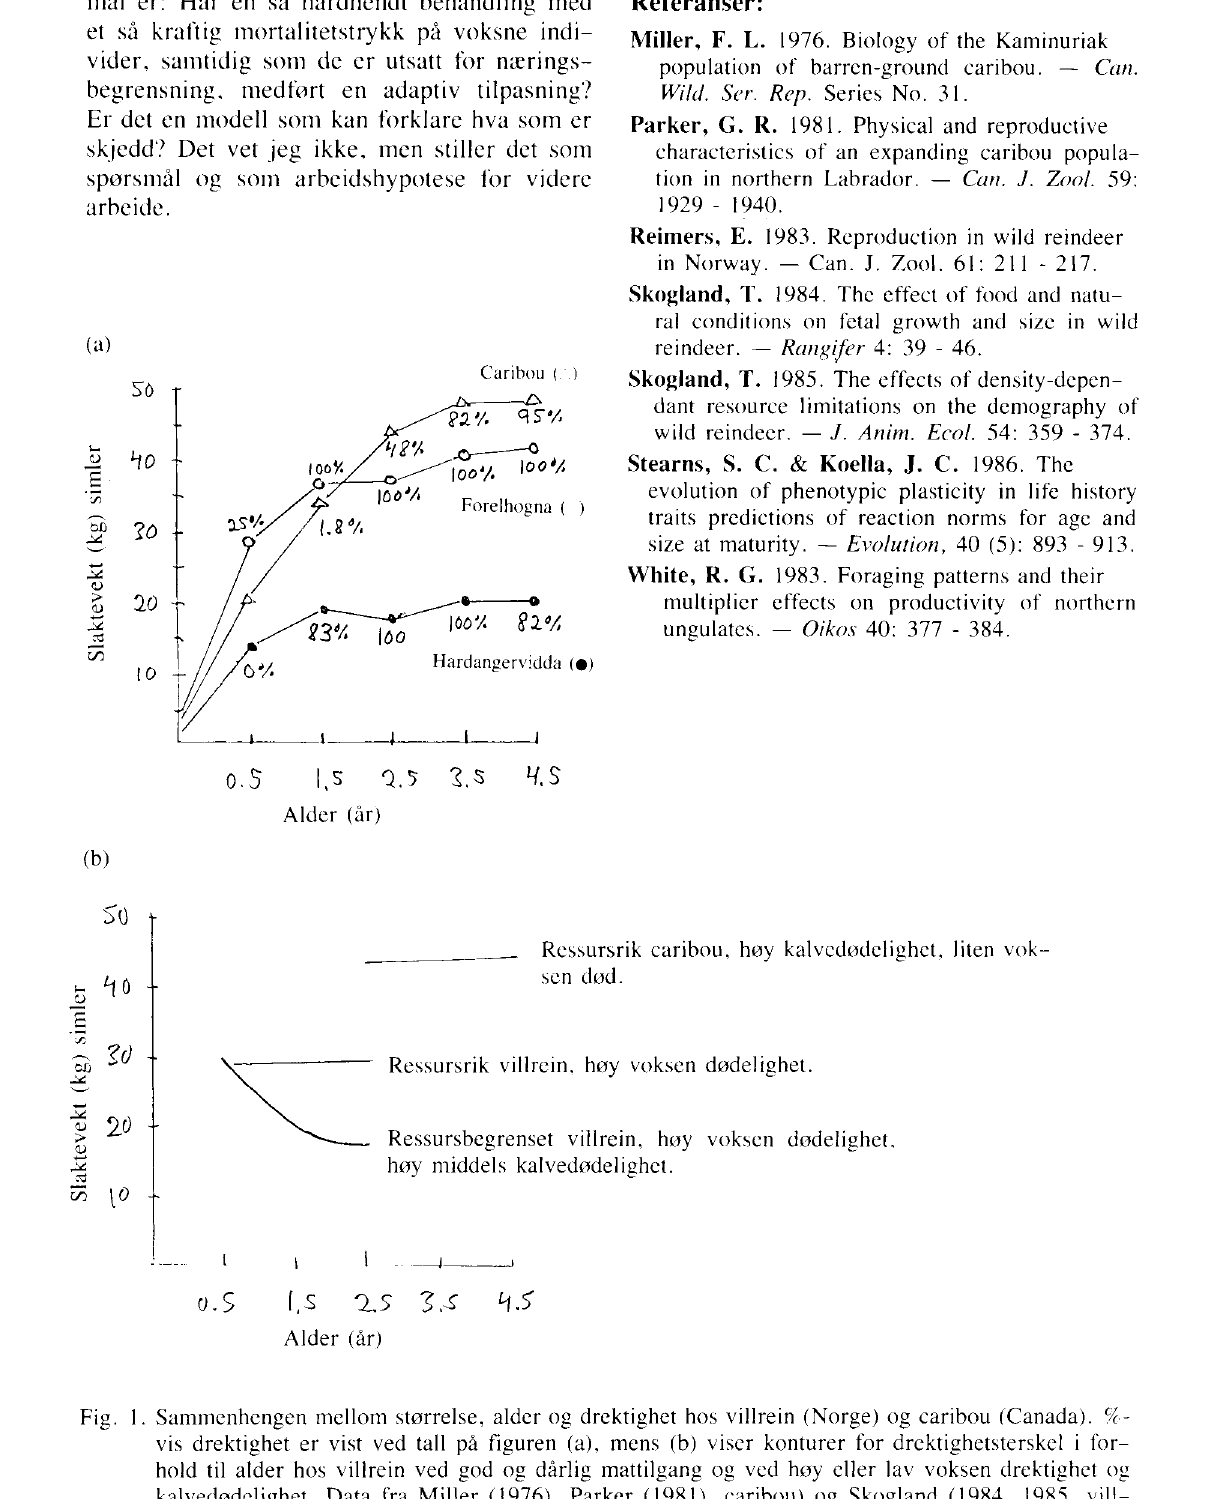
vider, samtidig som de er utsatt for nærings begrensning, medført en adaptiv tilpasning? Er det en modell som kan forklare hva som er skjedd? Det vet jeg ikke, men stiller det som spørsmål og som arbeidshypotese for videre arbeide.